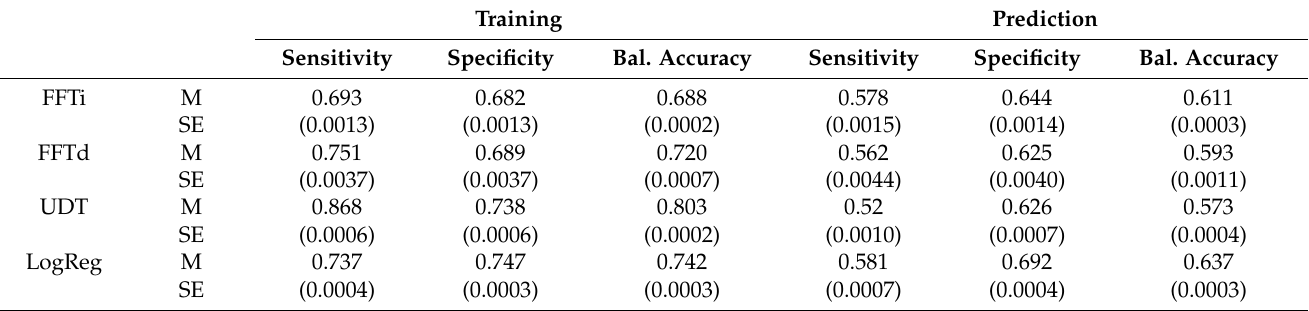
Table 2. Average performance for algorithms across trials with pre-operative information. The table presents means and standard errors separately for the four algorithms with the training set (fitting) and test set (prediction). For each combination, the table reports the mean and standard error of the mean for sensitivity, specificity and balanced accuracy across trials. FFTi, UDT and LogReg were tested in 10,000 trials and FFTd in the first 1000 of these only. Training Prediction